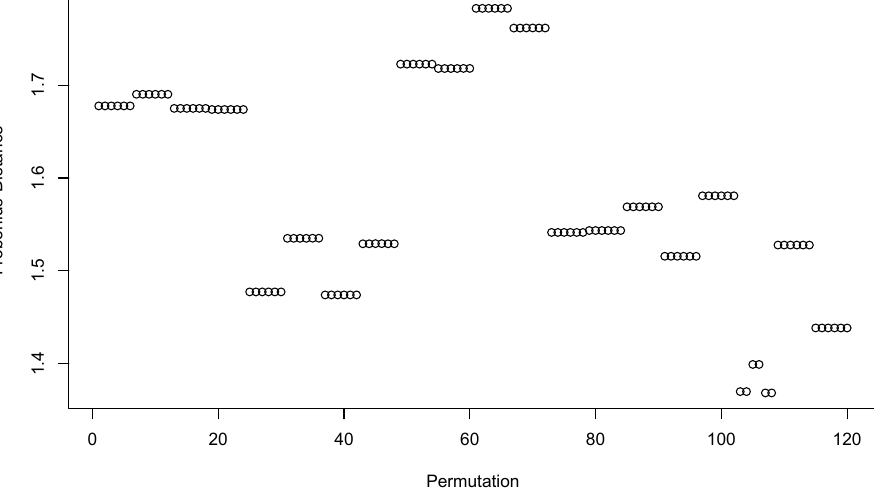
Figure 1. Impact of permutations on the Frobenius norm, in the case of G 51 and H 51